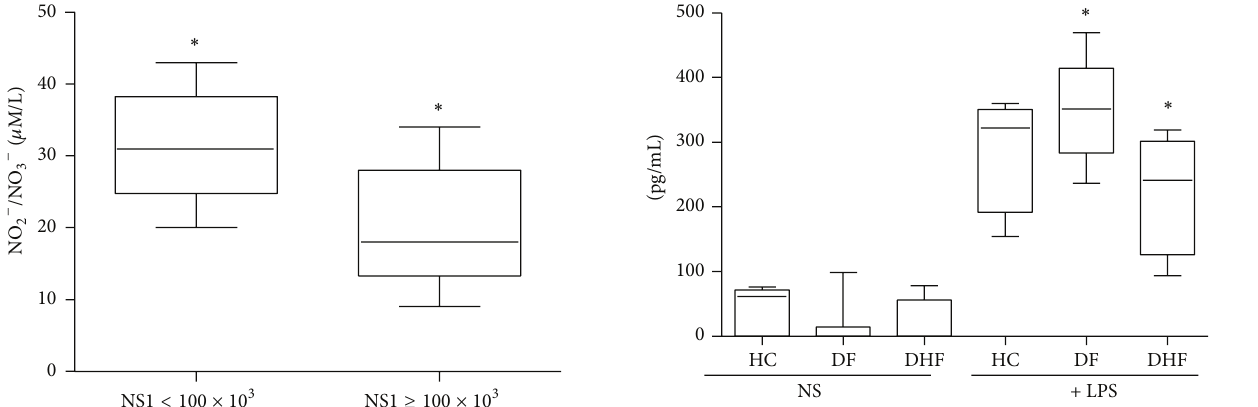
Figure 3: Nitric oxide serum levels ( 𝜇 M of NO 2− / NO 3− ) of dengue infected patients ( 𝑛 = 37 ) during the acute phase of the disease presenting low (NS1 < 100 × 10 3 BRU/mL) and high (NS1 ≥ 100 × 10 3 BRU/mL) dengue virus nonstructural protein 1 (NS1) serum levels measured by Griess reaction after reduction of serum samples with nitrate reductase. Results were expressed as median using a box plot. Equivalent symbols ( ∗ ) represent statistically significant differences ( 𝑃 < 0.05 ) between groups.